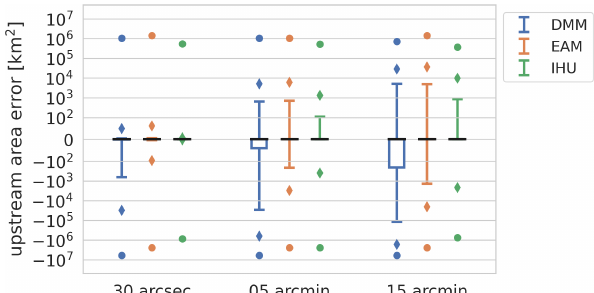
Figure 4. Absolute upstream area for the DMM (blue), the EAM (orange) and IHU (green) at three different resolutions from 30arcsec ( ∼ 1km; left column) to 15arcmin ( ∼ 30km; right col- umn), where the black lines indicate the median error, the box the 25th–75th percentiles, the whiskers the 1st–99th percentiles, the di- amonds the 0.1th–99.9th percentiles, and the dots the min and max